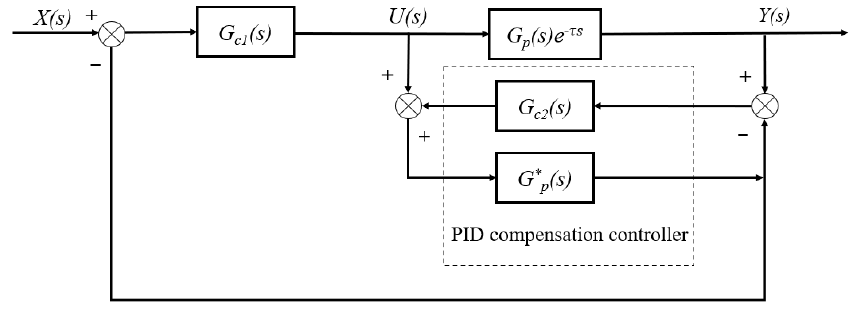
Figure 6. Structure of PID-Smith predictive compensator.